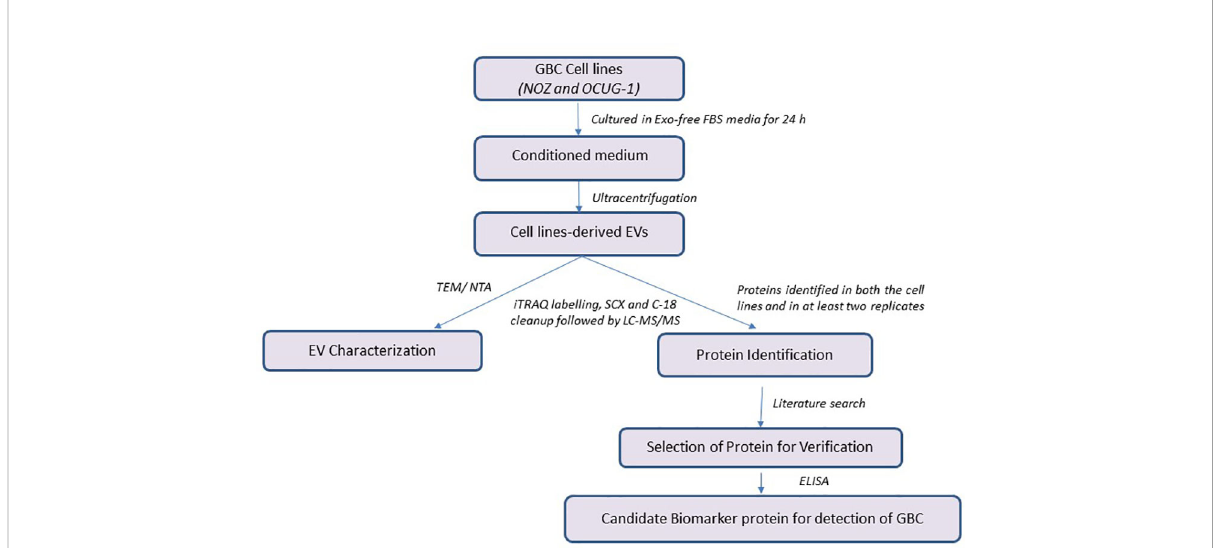
FIGURE 1 Work fl ow of the study. GBC, Gallbladder carcinoma; EV, Extracellular Vesicles; iTRAQ, Isobaric tags for relative and absolute quantitation; ELISA, Enzyme-linked immunosorbent